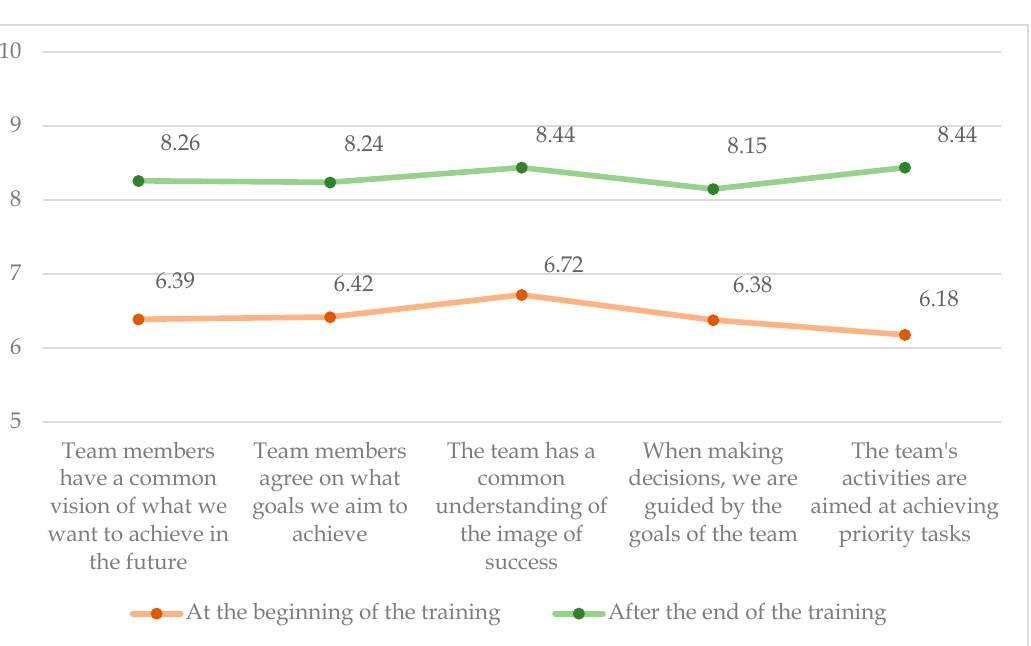
Figure 2. Results of answers to the block of questions “Formulation and translation of the team result vision” (in comparison of answers to questions at the beginning and after the end of the training).